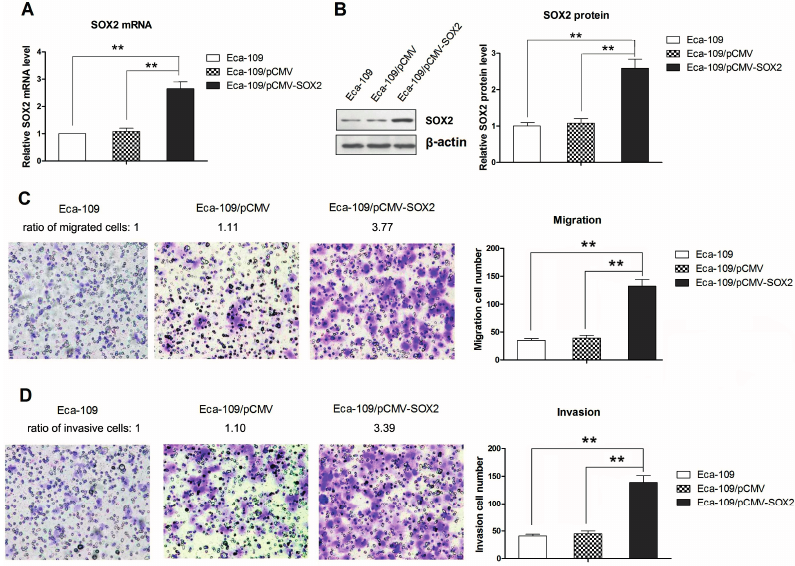
Figure 1. Over expression of SOX2 in Eca-109 cells and effect of SOX2 over expression on migration and invasion. ( A ) The SOX2 mRNA expression measured by qRT-PCR; ( B ) Western blot showing the SOX2 protein expression; ( C ) Cell migration assessed by Transwell chamber assay without Matrigel; ( D ) Cell invasion assessed by Transwell with Matrigel (200× magnification). Data are represented as mean ± SD of three separately conducted experiments. ** indicates p < 0.01. The Western blot and the images of Transwell chamber assay represent three independently conducted